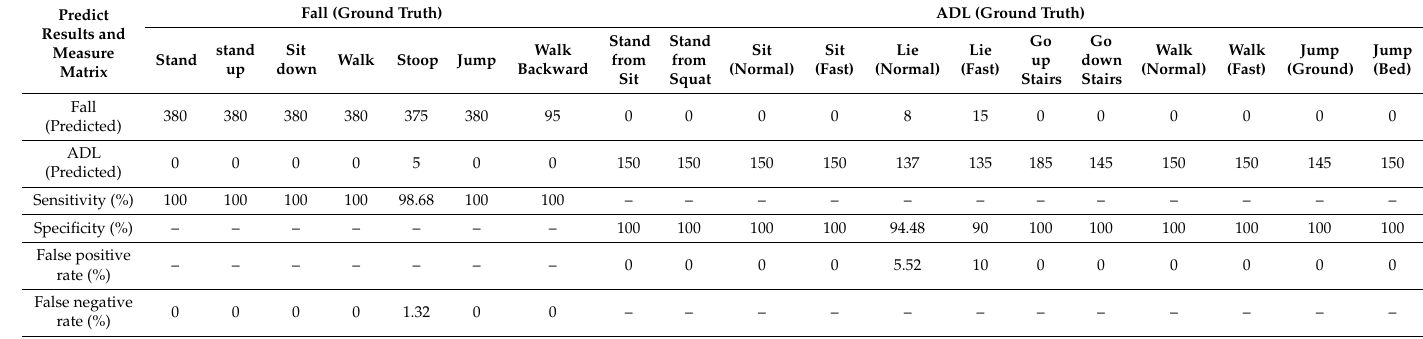
Table 6. The confusion matrix of the knowledge-based algorithm for each fall and ADL. The number of falls and ADLs is the total number of five-fold cross-validations over five rounds.